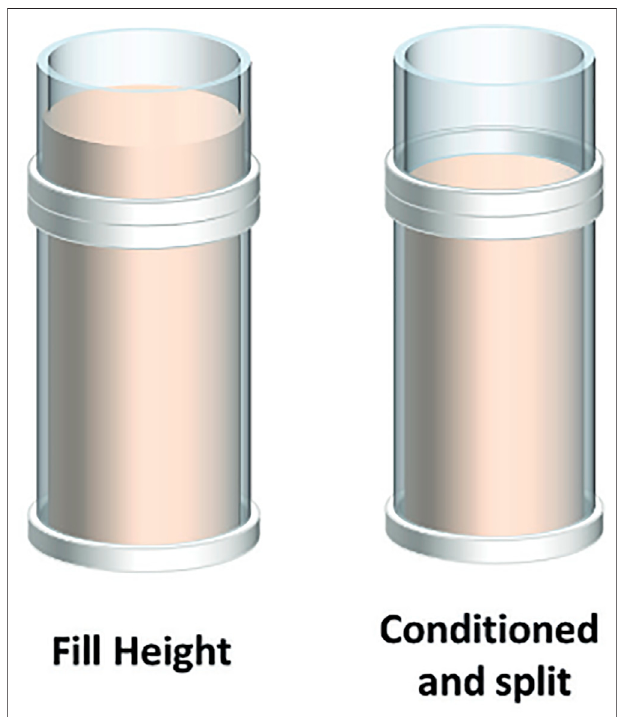
FIGURE 2 | Splitting mechanism on all the sample holders used in this work. Adapted with permission from Freeman et al. (2015).